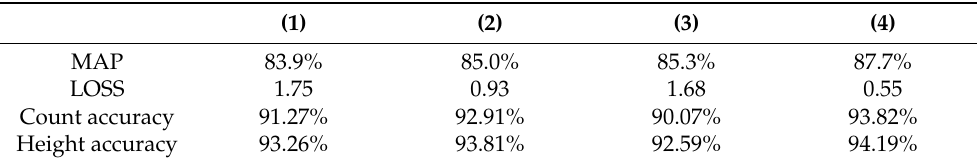
Table 7. Ablation